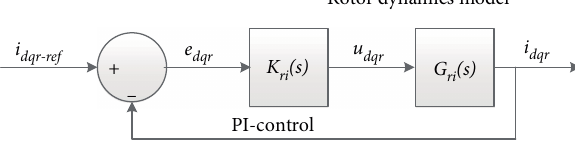
Figure 8: The PI current control (inner loop) structure of the RSC.